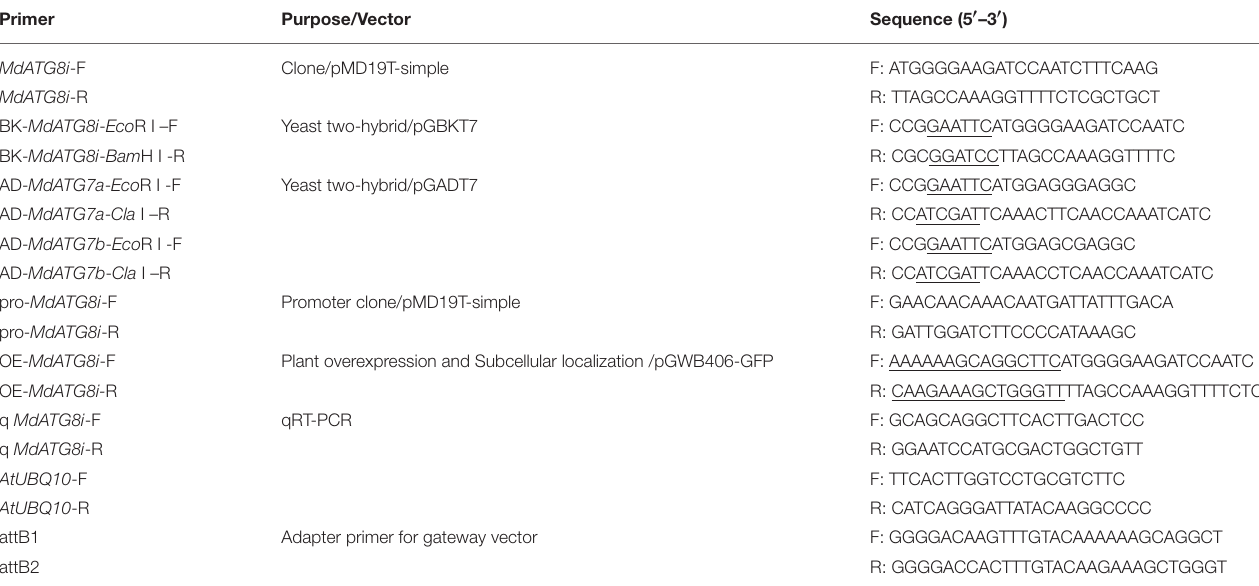
TABLE 1 | Primers used in this study.